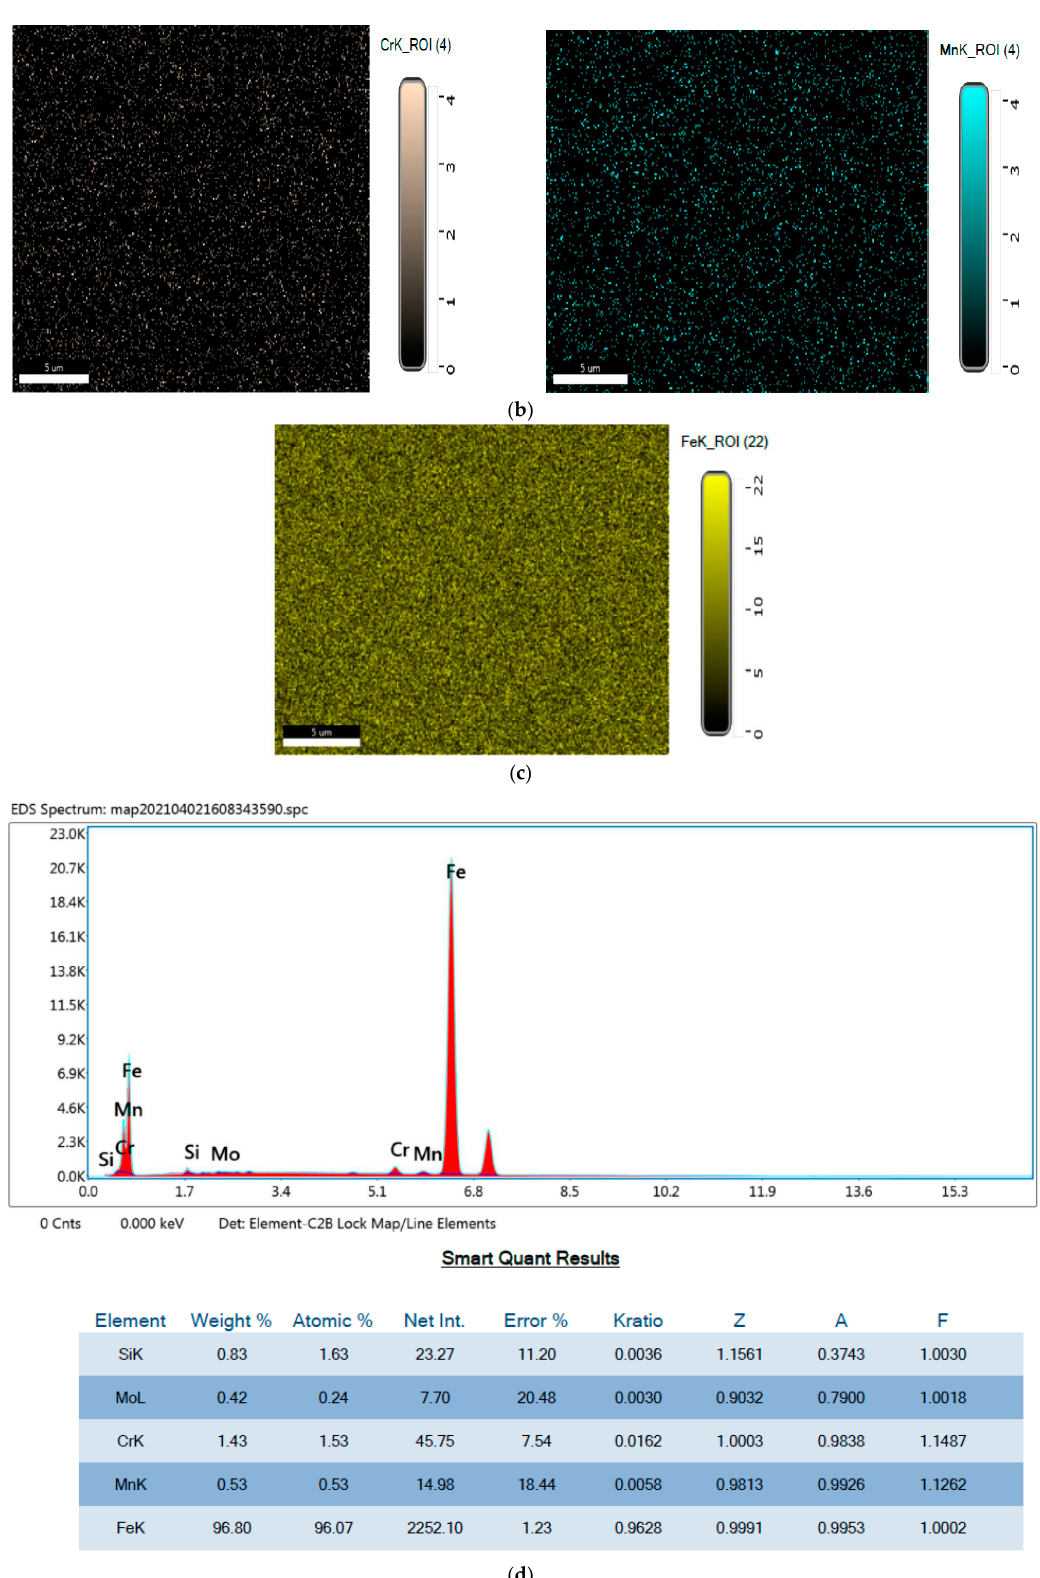
Figure 10. ( a ) EDS spectrum for the Si element from the 25CrMo4 steel sample. ( b ) EDS spectrum for the Cr element from the 25CrMo4 steel sample. ( c ) EDS spectrum for the Fe element from the 25CrMo4 steel sample. ( d ) The spot chemical analysis in the selected area for the 25CrMo4